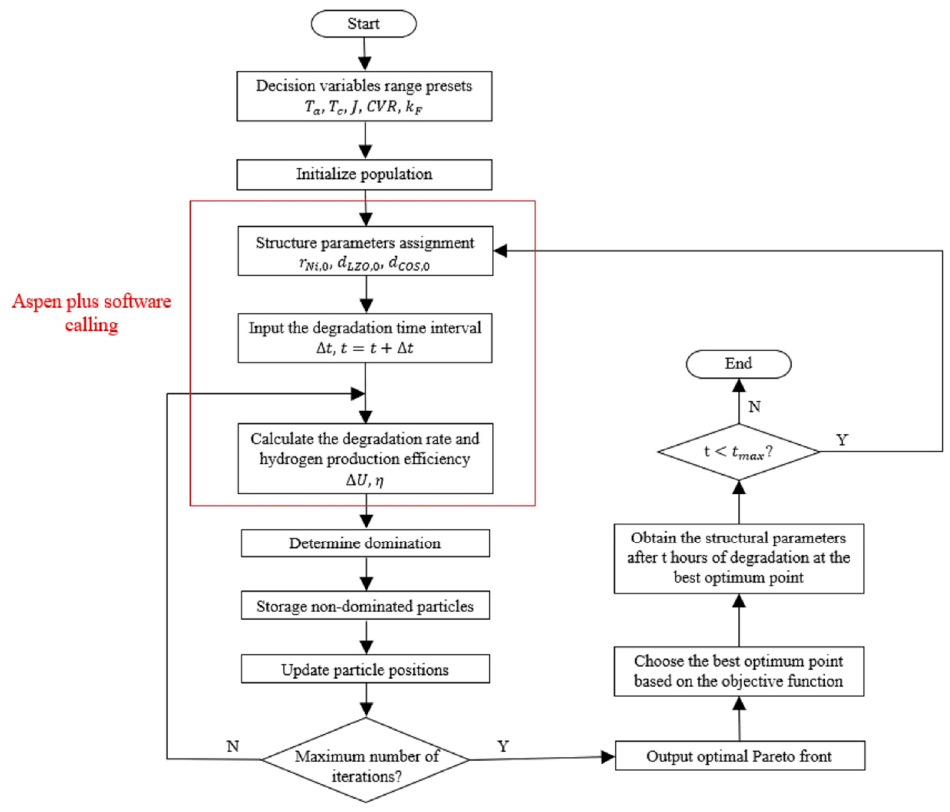
Figure 2. The flowchart for the online optimization procedure of the SOEC hydrogen production.